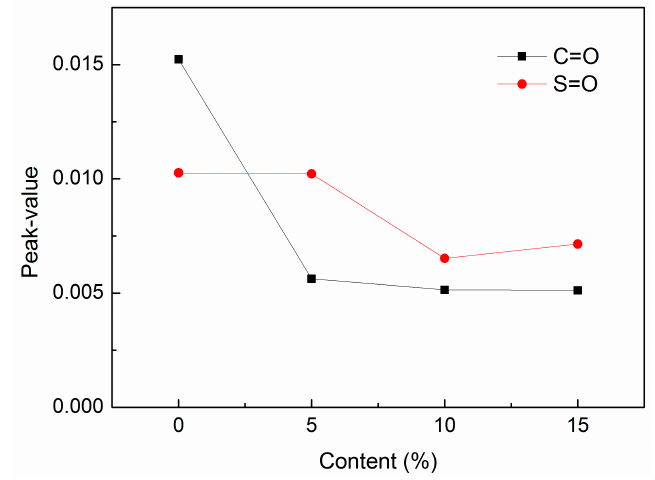
Figure 8. Peak value changes of carbonyl and sulfoxide groups after aging.